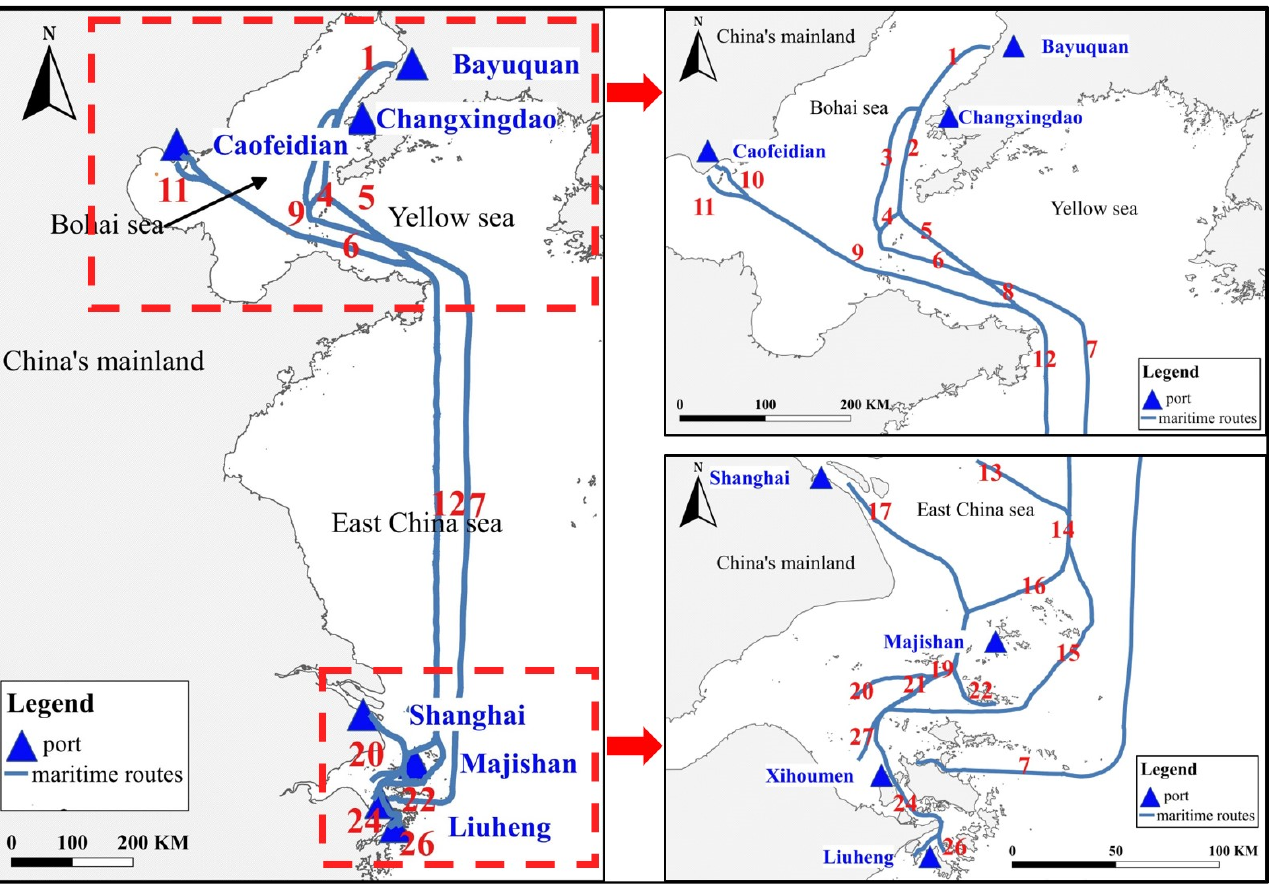
Figure 13. Maritime road segmentation results.